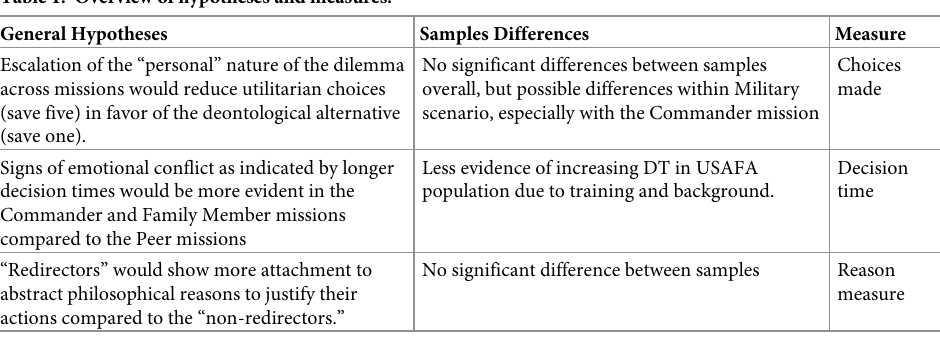
Table 1. Overview of hypotheses and